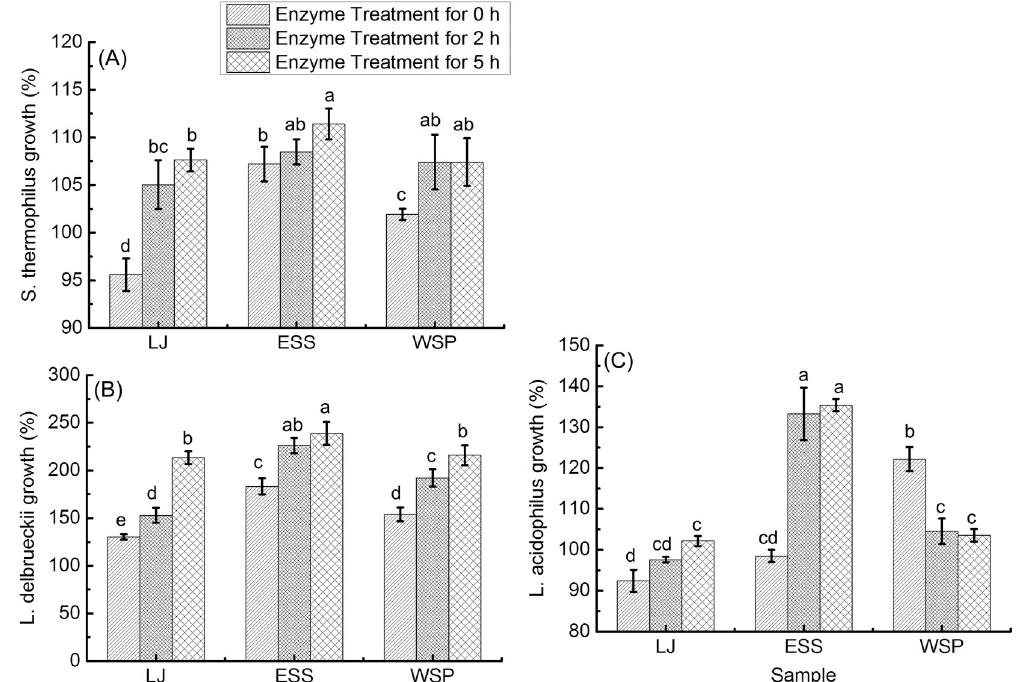
Figure 4. Influences of enzyme treated longan juices (LJ), their ethanol-soluble sugar (ESS) and water-soluble polysaccharide (WSP) components in longan juices after enzyme treatment for 0 h, 2 h and 5 h on the growth stimulation activity of ( A ) S. thermophiles (%), ( B ) L. delbrueckii (%) and ( C ) L. acidophilus (%). The values were calculated on the basis of glucose activity (taken as 100%). Different letters on the bars indicate significantly different ( p < 0.05).